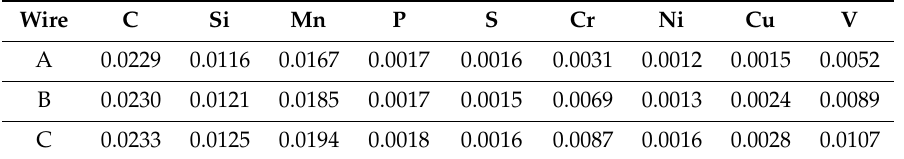
Table 2. Measurement uncertainty for chemical composition (%).